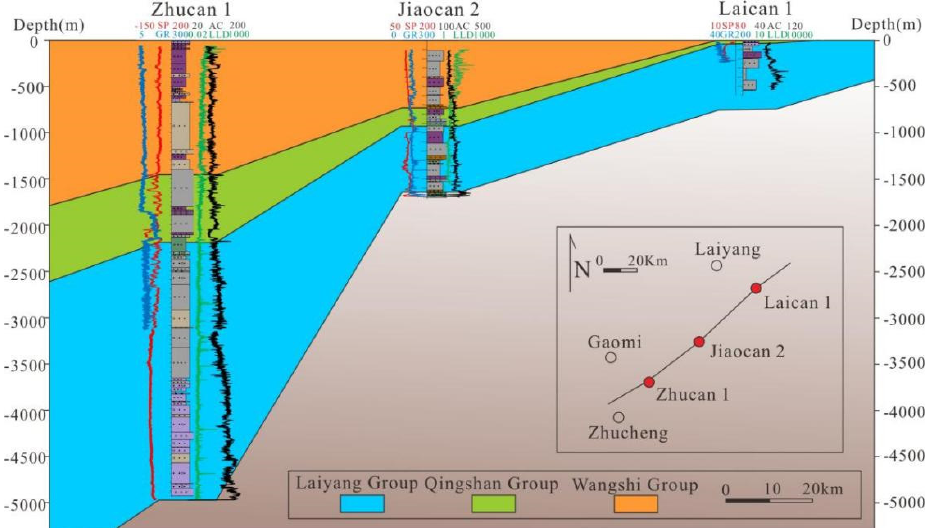
Figure 2. Comparison of Mesozoic SW − NE trending strata across Zhucan 1 − Jiaocan 2 − Laican 1 wells in the Jiaolai basin.